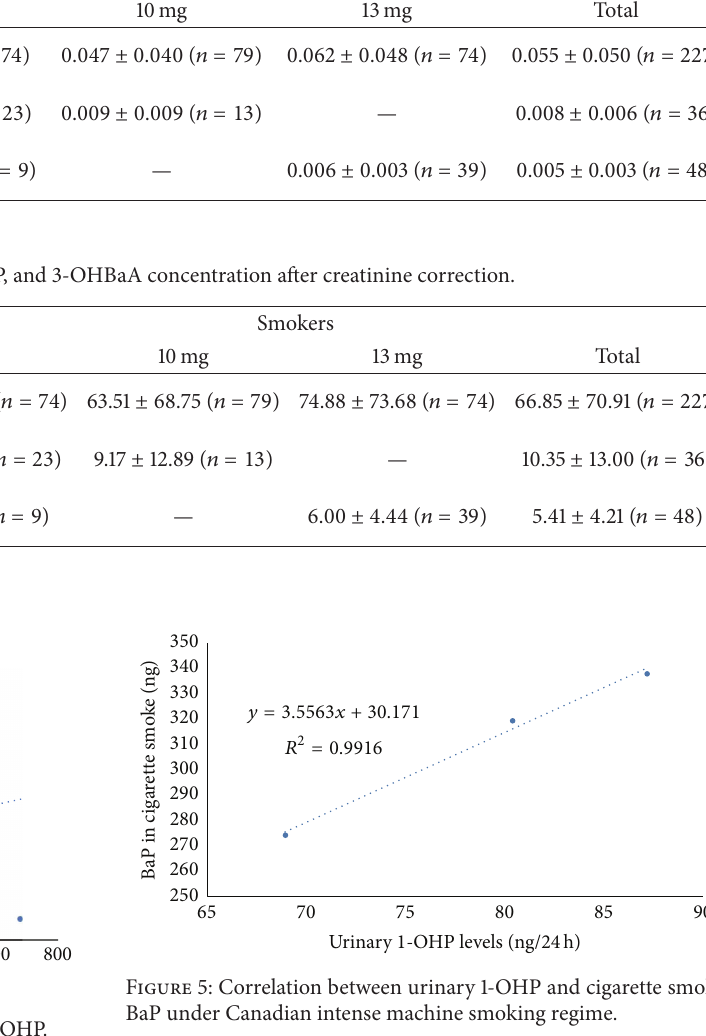
Figure 4: Correlation between urinary cotinine and 1-OHP.